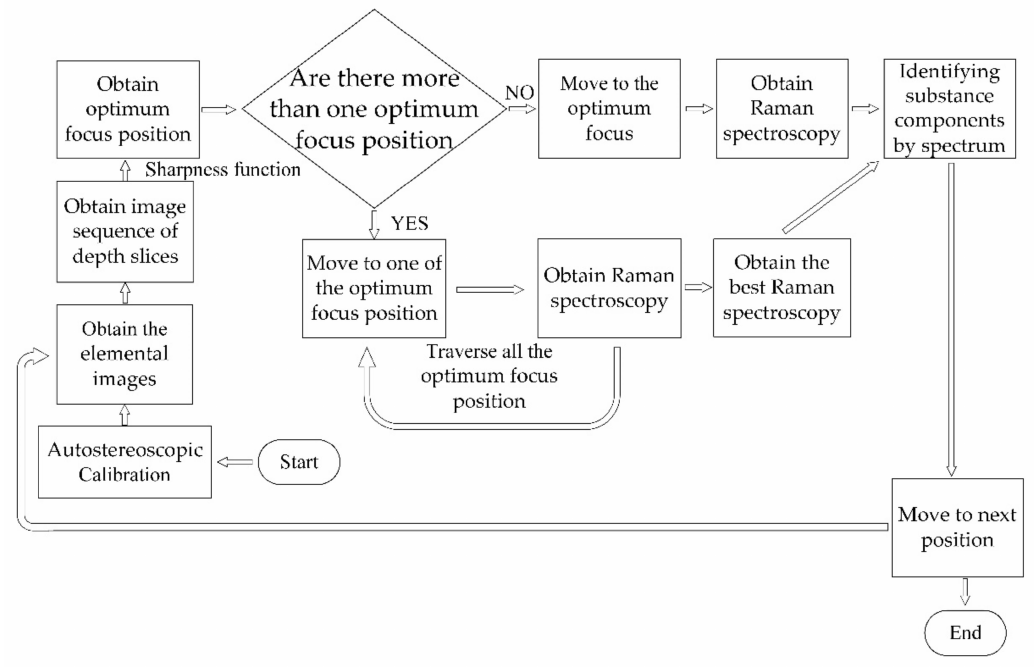
Figure 4. The data collection and processing procedure of the proposed ARS